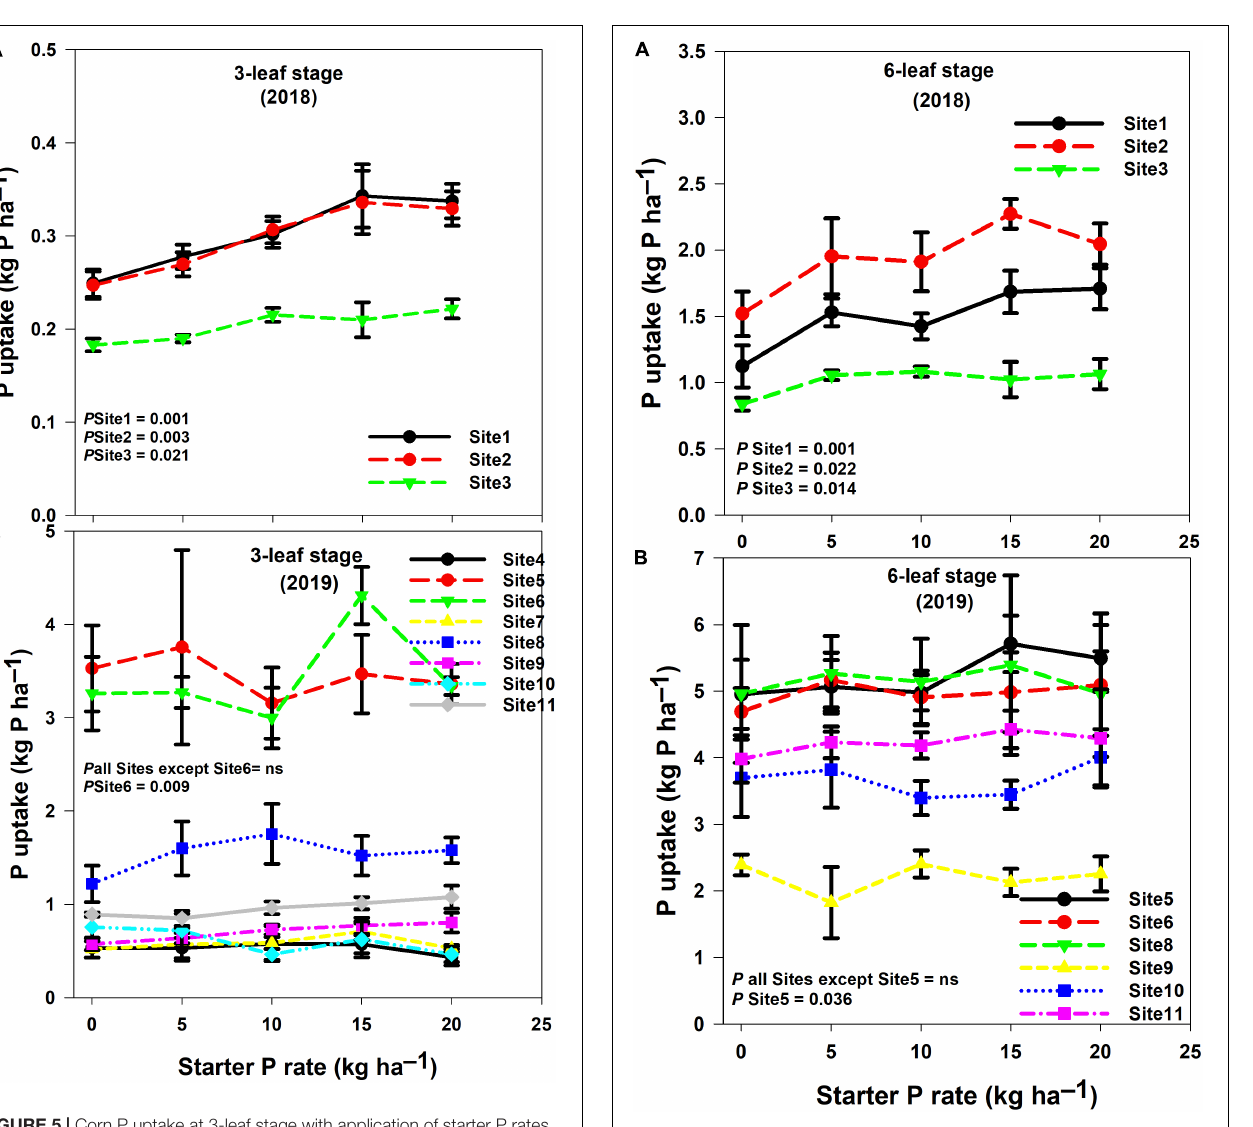
FIGURE 6 | Corn P uptake at 6-leaf stage with application of starter P rates and dairy manure across 11 sites [2018 (A) and 2019 (B) ] in the Fraser Valley, BC. Dairy manure was applied at 6-leaf stage. Error bars represent standard deviations of the